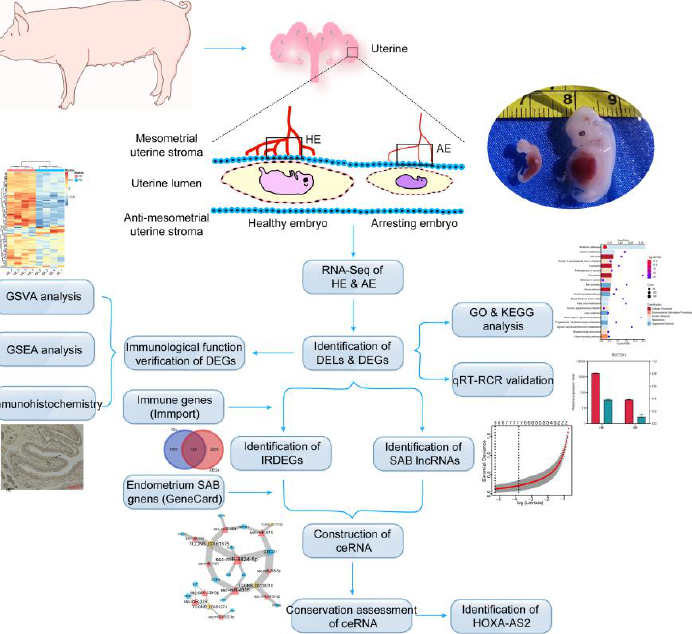
Figure 1. Flowchart of the study. The photograph of the embryos corresponds with the pattern diagrams, which demon- strate the healthy or arresting embryos at day 28 of pregnancy. Details of the methods and results are described later.